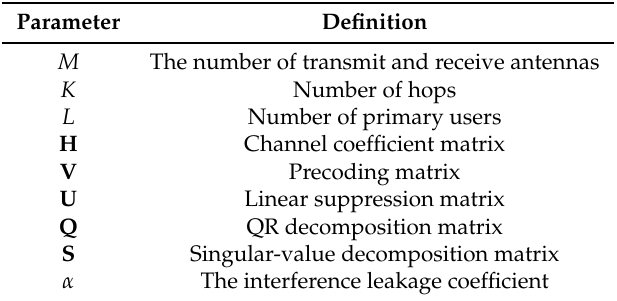
Table 1. Parameters of the proposed